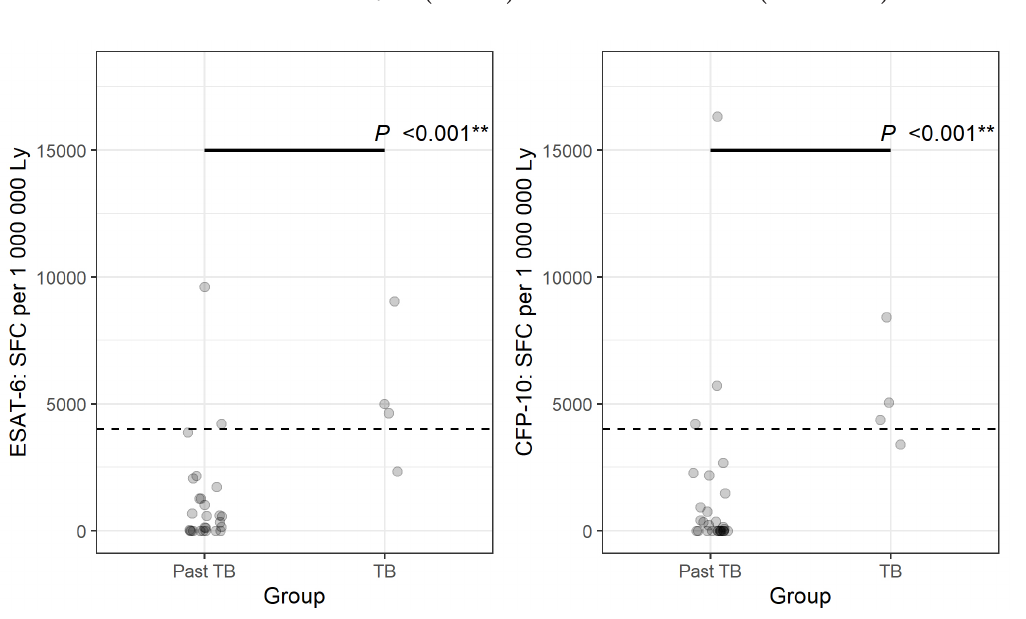
Figure 2 . Number of spot-forming cells (SFCs) for early secretory antigenic target (ESAT)-6 and culture filtrate protein (CFP) 10 specific bronchoalveolar lavage cells per 1 million lymphocytes in 44 individuals with a prior tuberculosis episode and recurrence and those without recurrence. All 4 patients diagnosed with active tuberculosis had more than 4000 SFC after stimulation with either ESAT-6 or CFP 10 or both interpreted as a positive